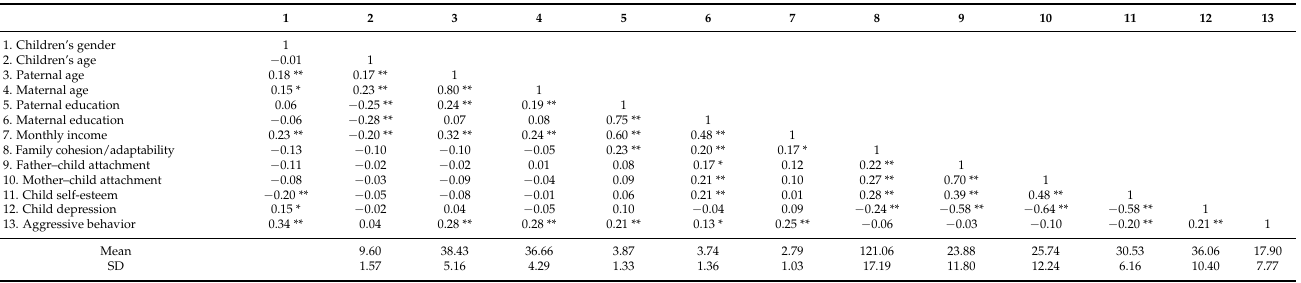
Table 1. Means, Standard Deviations, and Correlations Among Study